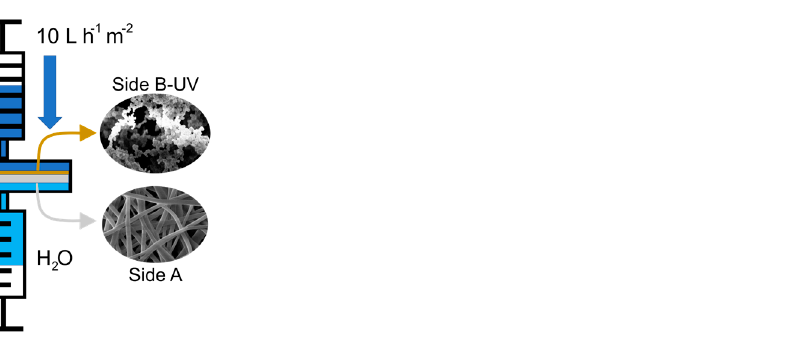
Figure 2. Schematic representation of the dead-end filtration apparatus used for the toluene adsorp- tion experiment.